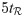
Pathogen invasion conditions and average time to extinction for the Burkina Faso settlement network.The values of the dominant eigenvalue g
0 of the GRM are plotted for increasing values of α ∈ {0.0001, 0.001, 0.01, 0.1} (respectively in panels (a) to (d)), against values of maximal contamination and exposure rates θ
MAX and the fraction of mobile people m. Yellow indicates parameter combinations permitting parasitic invasion. Contours to the left of the stability boundary give pathogen extinction time isolines (5tR) of 25, 50 and 100 years.